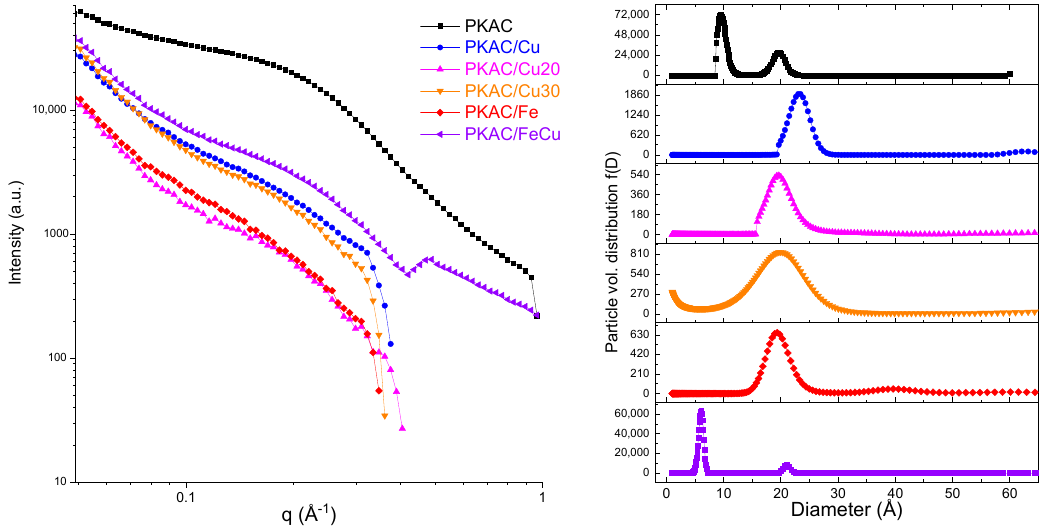
Figure 5. SAXS profiles and size distribution of monometallic and bimetallic catalysts.